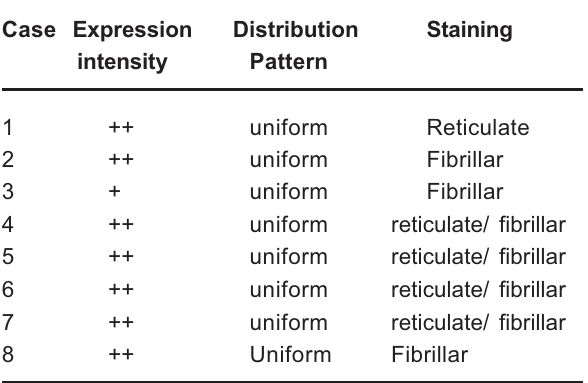
TABLE 3- Tenascin expression intensity, distribution and staining pattern in interstitial extracellular matrix of the central giant cell granulomas of the jaws